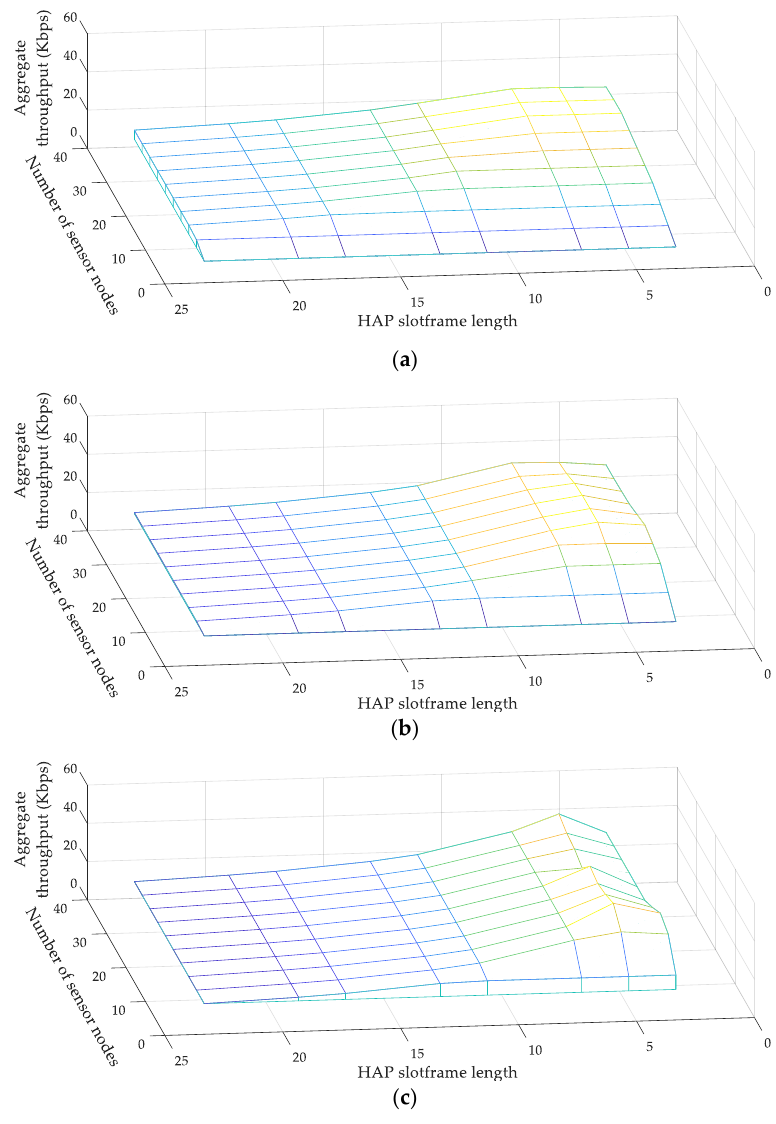
Figure 6. Aggregate throughput of MCSS: ( a ) one, ( b ) two, and ( c ) four packets/s. However, the priority of a cell in the HAP slotframe is always higher than that of a cell in the WPT slotframe. Accordingly, when the HAP slotframe length is very short (i.e., three), the number of data packets transmitted from the sensor node to the CH in the WPT slotframe decreases, and as a result, the aggregate throughput decreases. In the figure, the